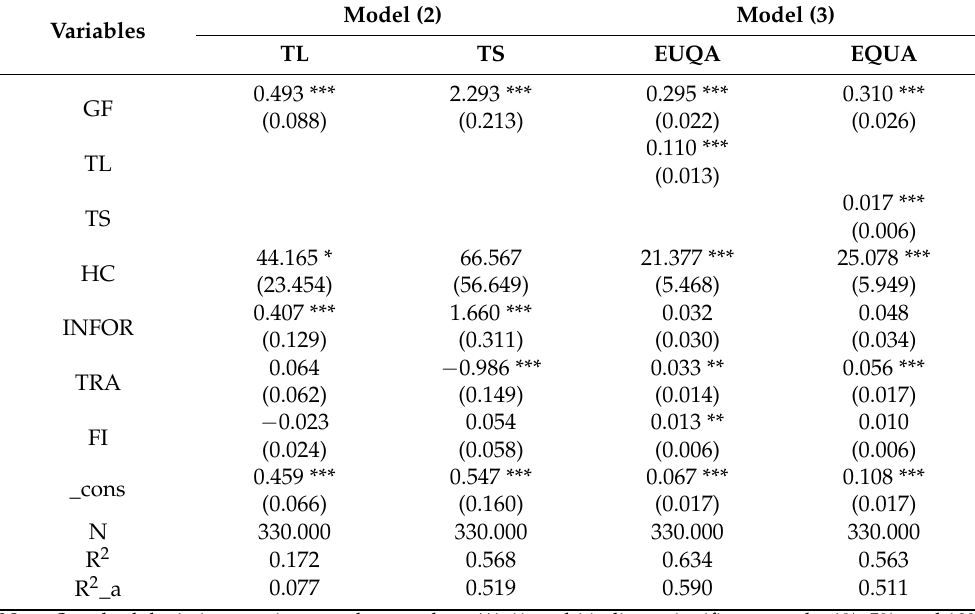
Table 5. Intermediary model regression